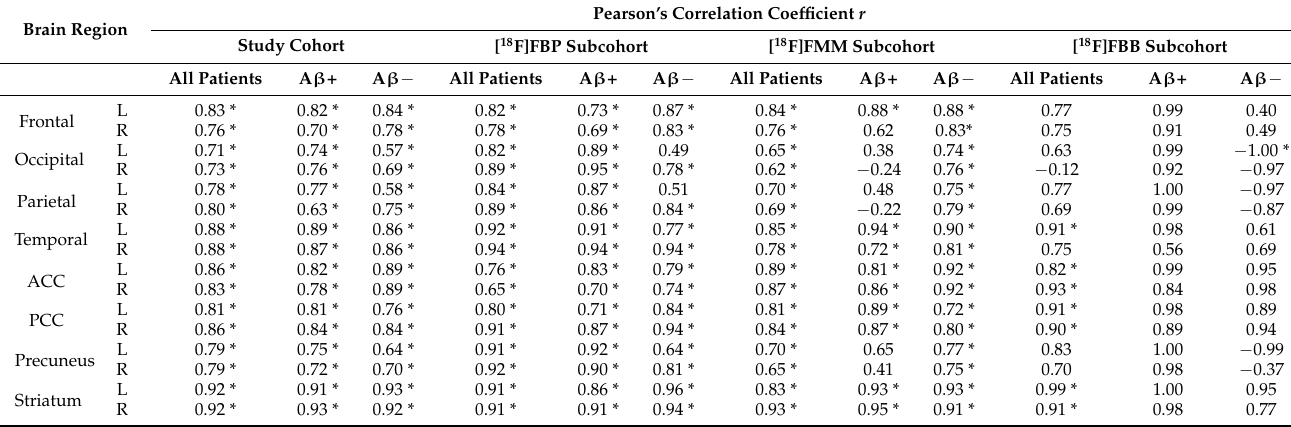
Table 4. Regional interpatient correlation coefficients of FMF and [ 18 F]FDG PET. * statistically significant FDR-adjusted p -value.